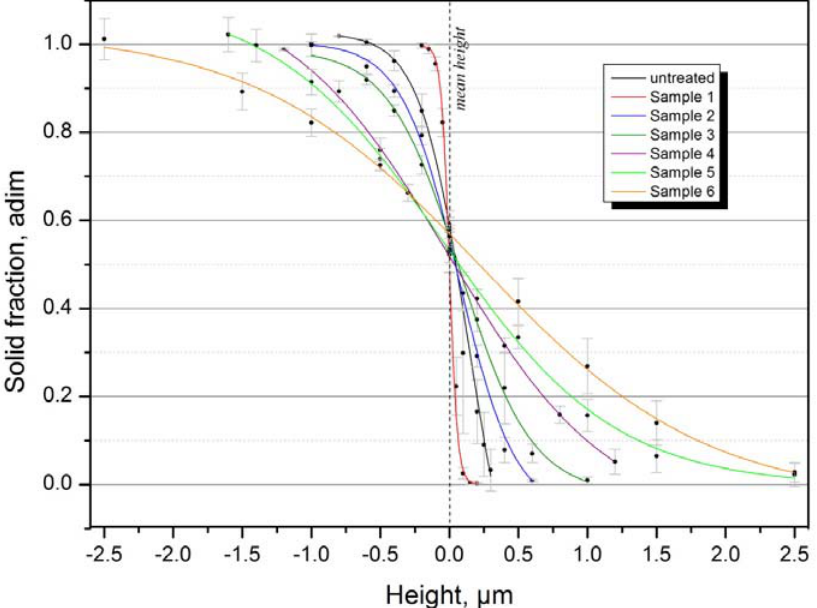
Figure 12. The sigmoidal “DoseResp” correlation between topography and solid fraction. Error bars are the standard deviations.